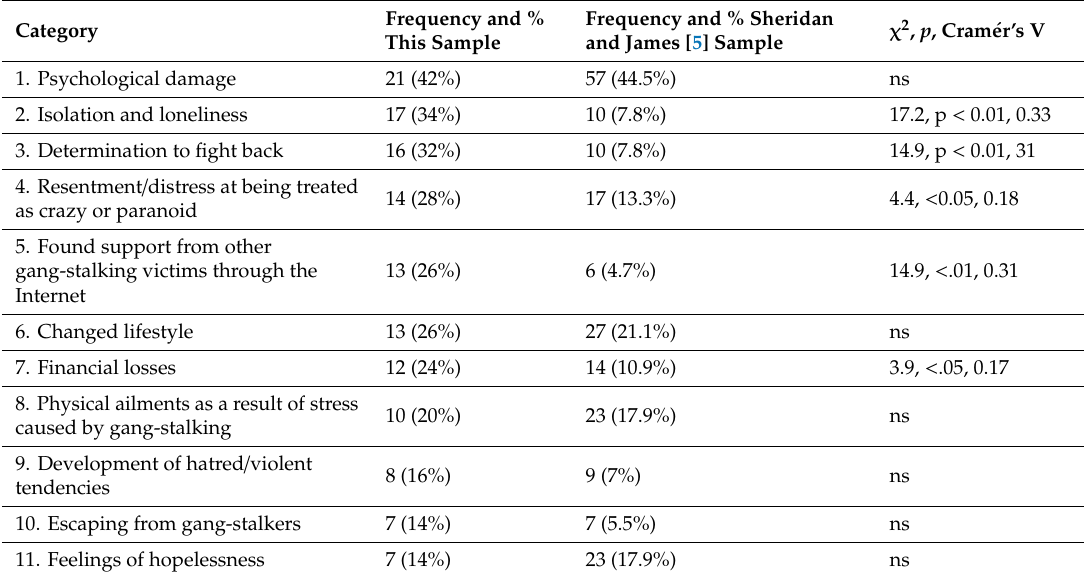
Table 4. Comparisons between content analyses of internet and questionnaire data on sequelae of being